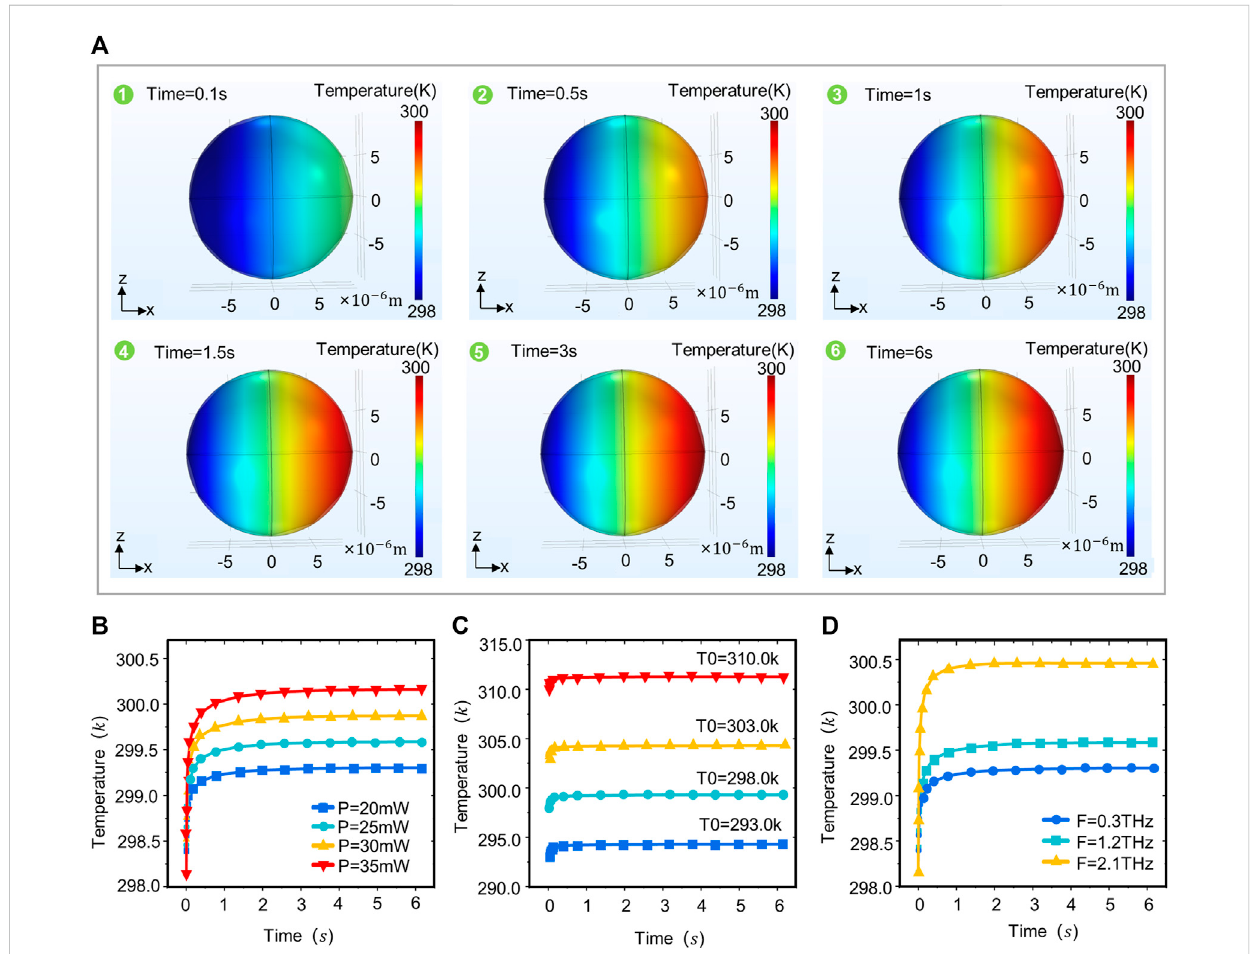
FIGURE 3 Temperature distribution patterns in neurons under different terahertz radiation parameters. (A) The XZ plane temperature of neurons varies with terahertzradiationtime(Simulationtime:6 s,Initialtemperature:293.0 k,r=10 um,F=1.2 THz, p =20 mW). (B) Variationoftemperatureinneuronswith time at different terahertz radiation powers (simulation time: 6 s, initial temperature: 293.0 k, r = 10 um, F = 1.2 THz, p = 20, 25, 30, 35 mW). (C) Variation oftemperatureinneuronswithtimeatdifferentinitialtemperatures(simulationtime:6 s,initialtemperature:293.0,298.0,303.0,310.0 k,r=10 um, F = 1.2 THz, p = 20 mW). (D) Temperature variation in neurons with time at different terahertz radiation frequencies (simulation time: 6 s, initial temperature: 293.0 k, r = 10 um, F = 0.3, 1.2, 2.1 THz, p = 20